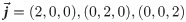
Comparison between j→=(2,0,0),(0,2,0),(0,0,2) (top) and j→=(0.5,0,0),(0,0.5,0),(0,0,0.5) (bottom).